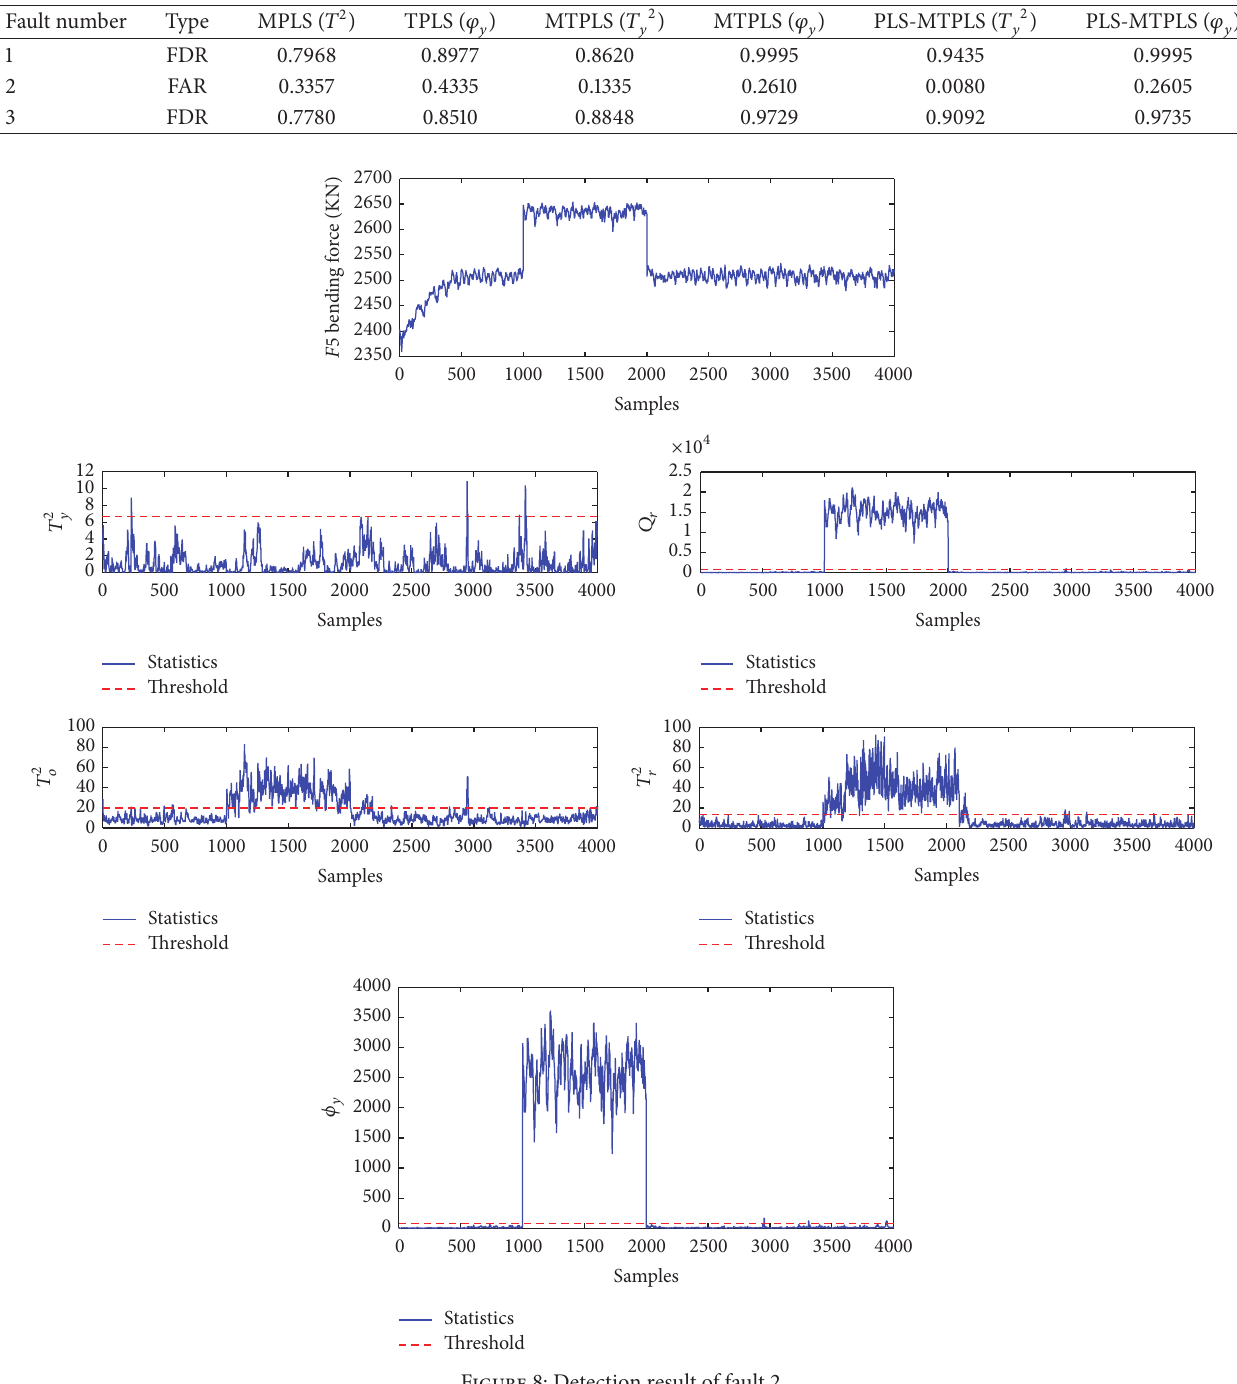
Table 2: Detection performance comparison.